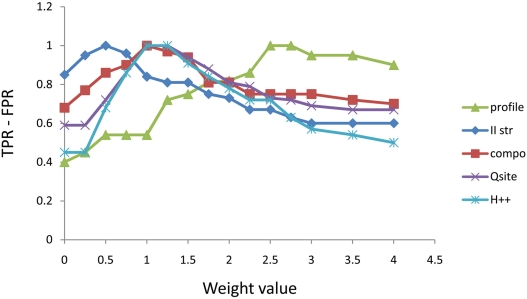
Effect of variation in parameter used on method performance.In the figure, the difference between True Positive Rate (TPR) and False
Positive Rate (FPR) for each parameter weight is plotted. True positives
included correctly predicted thiol oxidoreductases from the Test Case
(Table S3), and false positives control proteins (Table
S3) predicted as thiol oxidoreductases (i.e., containing a Cys
scoring higher than the cut-off). A Y-axis value of 1 indicates complete
separation of the dataset. Starting from the optimized weights described
in the text, each parameter was varied separately in the range
0–4 (X-axis values). The graph should be read as follows: each
parameter is represented by a curve, and each point represents the
TPR-FPR value (the higher the better) for a specific weight. Maxima
represent the best scoring values (compare to Figure 1A). Decreased values to the
right of the maximum reflect a tendency of the parameter to give False
Positive predictions when over-weighted, while when on the left, it
corresponds to a tendency to underestimate the number of True Positives
when the parameter is under-weighted. This analysis provides insights
into variability introduced in the performance when the parameter
weights are changed, in particular showing that the optimized parameters
cannot vary in a broad range of values. However, for two parameters
alternative values were possible: the Profile scoring (values could vary
in the range 2.5-÷2.75) and the H++
contribution (1÷1.25). For all other parameters, clear maxima
(corresponding to the optimized values described in the text) were
observed.